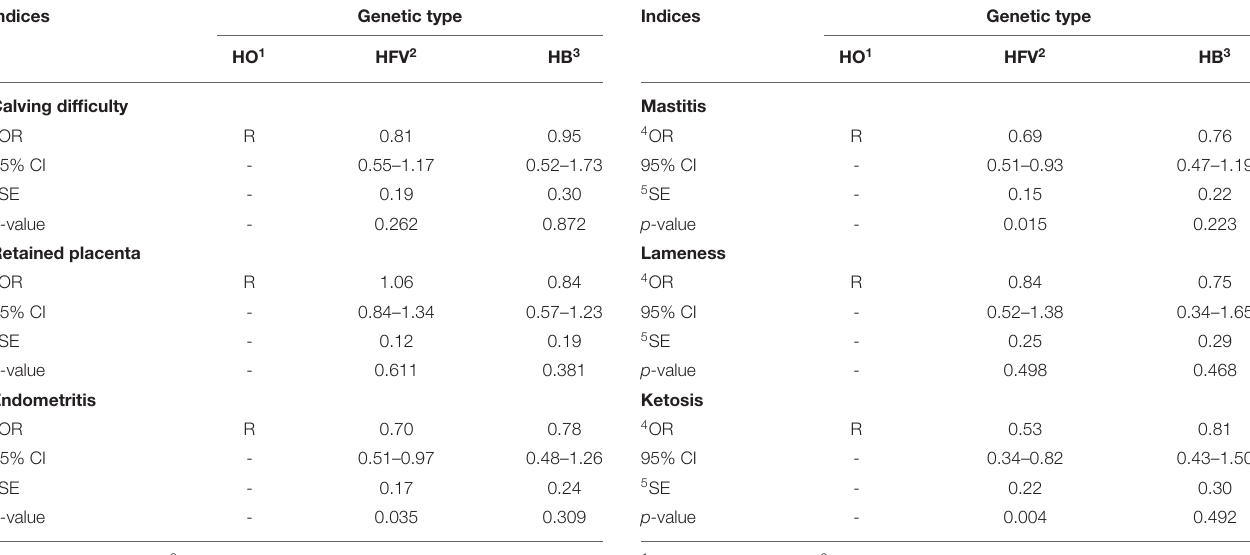
TABLE 5 | Odds ratio for general health indices of purebred Holstein, Holstein × Fleckvieh, and Holstein × Brown Swiss cows. Indices